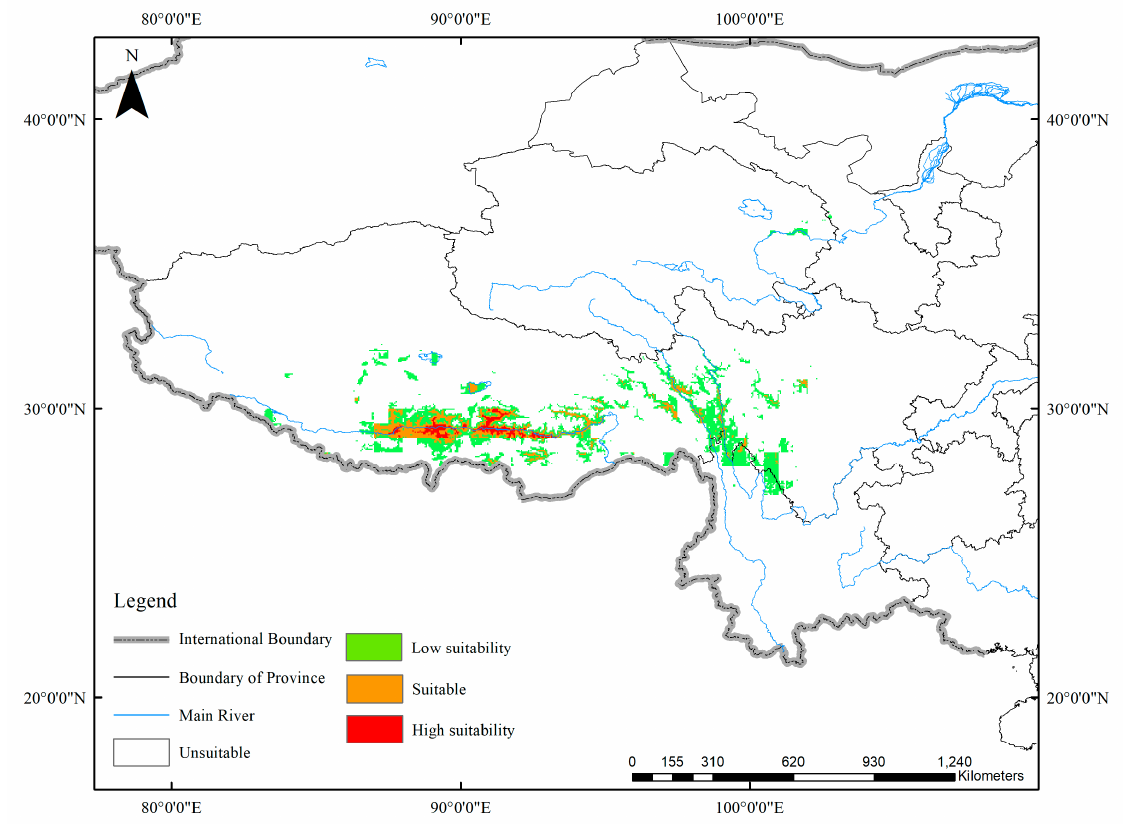
Figure 2. Suitable habitat distribution of S. moorcroftiana under the current environment. Table 2. The contribution of key environmental factors to modeling S. moorcroftiana (Benth.) Baker habitat distribution derived from the MaxEnt model .